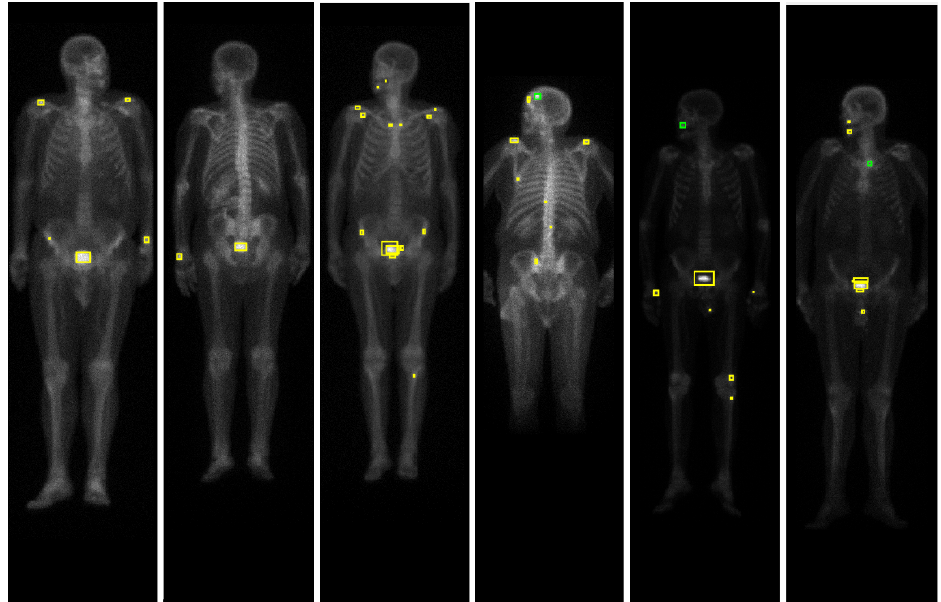
Figure 4. Results of the detection algorithm in bone scintigraphy images from the nonmalign set. The colours of the bounding boxes were manually chosen for the purposes of illustration, according to the respective medical report of the patient: red represents metastases, green represents benign bone lesions and yellow represents false positives (hotspots that are neither malign nor benign lesions).